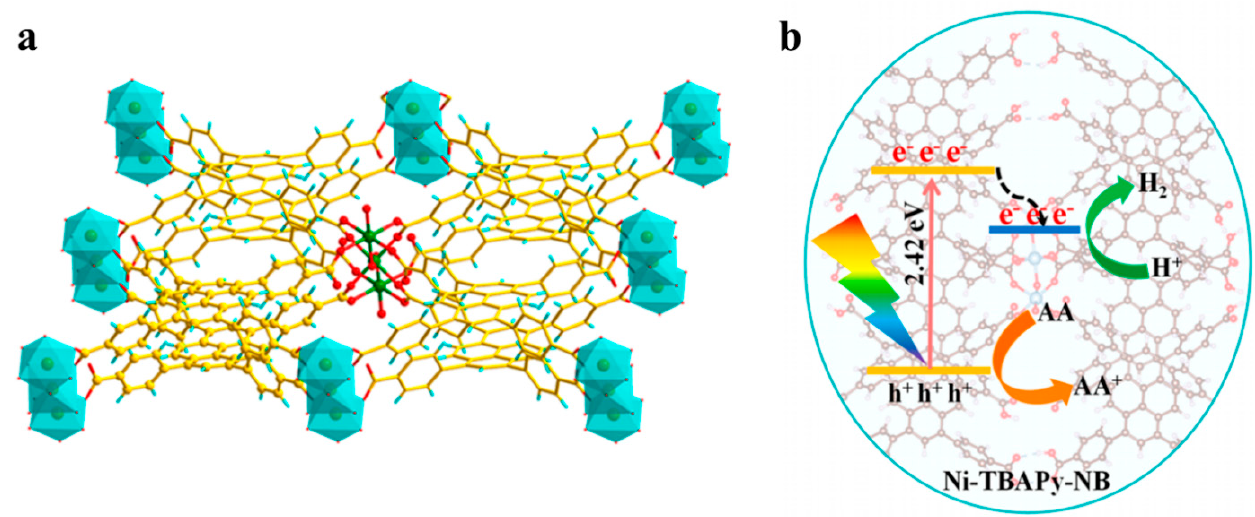
Figure 3. ( a ) The 2D structure of Ni-TBAPy-SC and the coordinated environment of middle [Ni 3 O 16 ] SBU. Color: red, O; yellow, C; green, Ni; cyan, H. ( b ) The schematic diagram of the photocatalytic hydrogen evolution reaction for Ni-TBAPy-NB. Reproduced with permission from Ref. [63].